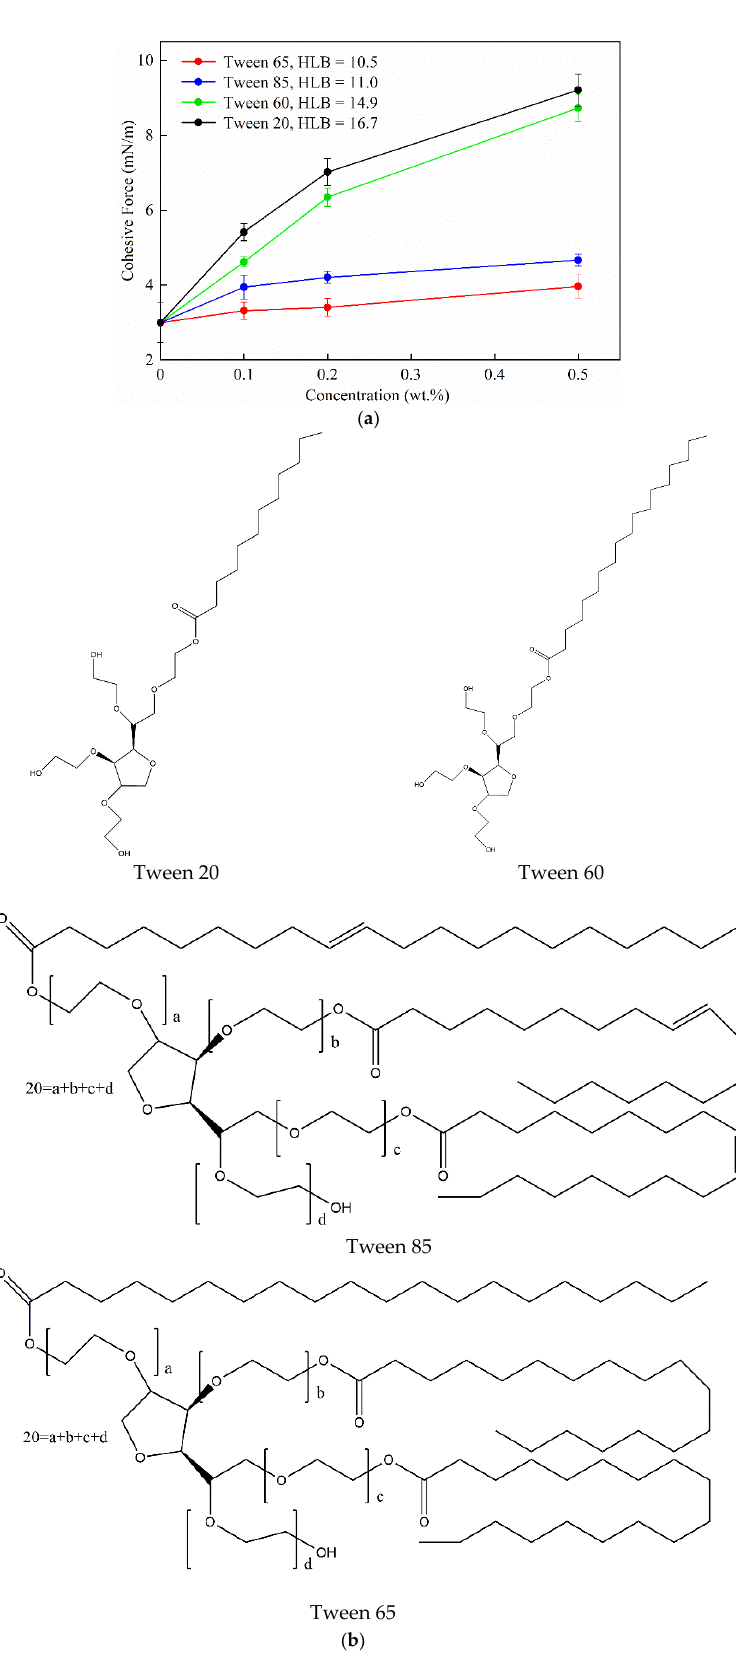
Figure 4. ( a ) Variation of cohesive force between hydrate particles with the concentration of Tween surfactants (−1 °C, 2.2 mN/m, 10 s) ; ( b ) molecular structure diagram of Tween series surfactants [27]. surfactants ( − 1 ◦ C, 2.2 mN/m, 10 s); ( b ) molecular structure diagram of Tween series surfactants